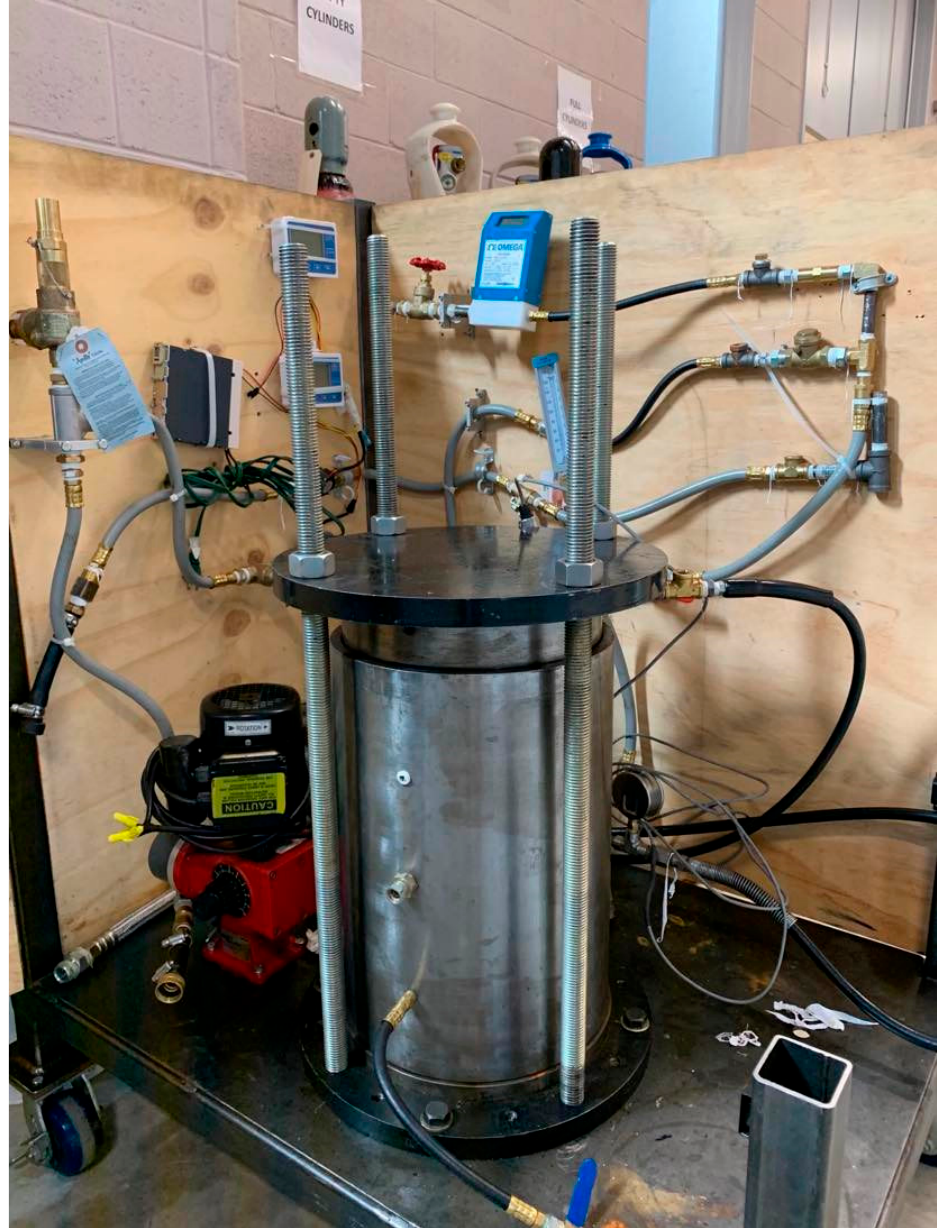
Figure 1. Experiment Setup, Radial Flow Facility.